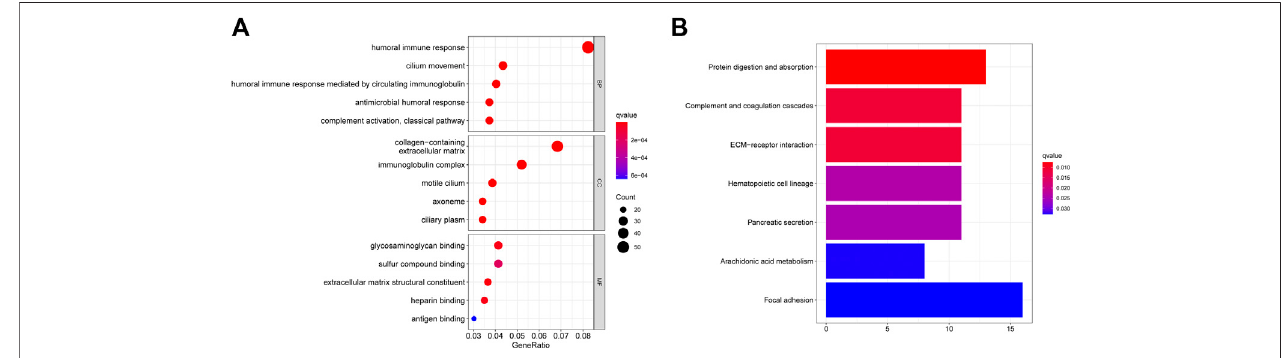
FIGURE 9 | GO and KEGG enrichment analysis between high risk score group and low risk score group. (A) GO enrichment between the high-risk patients and low-risk patients in TCGA cohort. (B) KEGG pathways between the high-risk patients and low-risk patients in TCGA cohort.